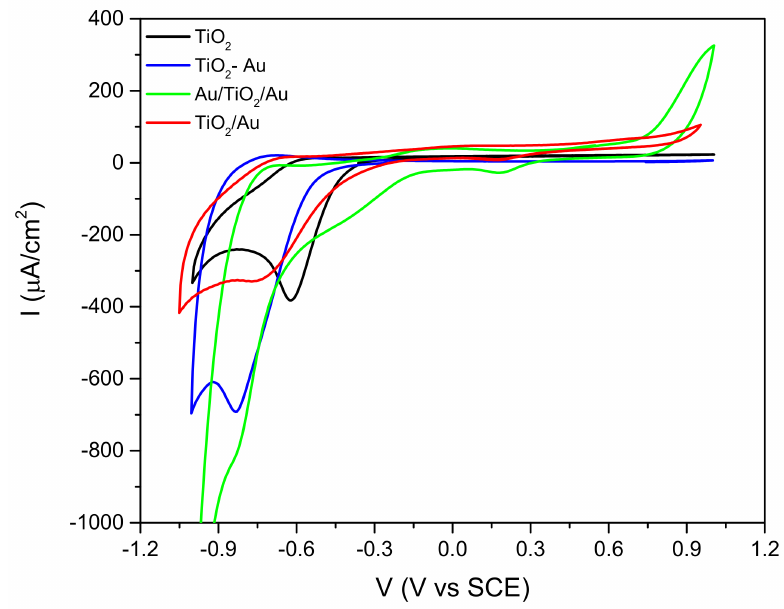
Figure 9. Comparison between CV in supporting electrolyte at different irradiated